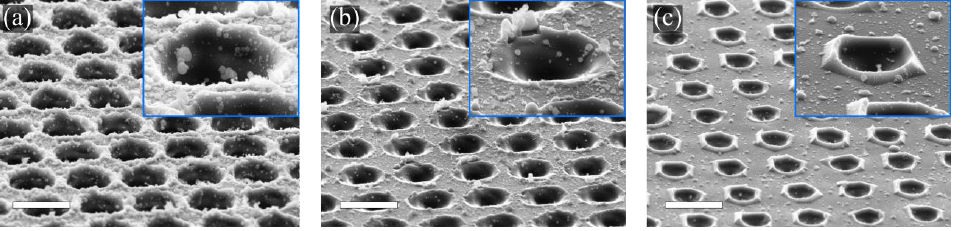
Figure 4. Optical image of the GaSe surface with ARMs, inscribed at E = 37.5 nJ and numbers of pulses N = 1, 3, 5, and 8 on both sides of the sample.